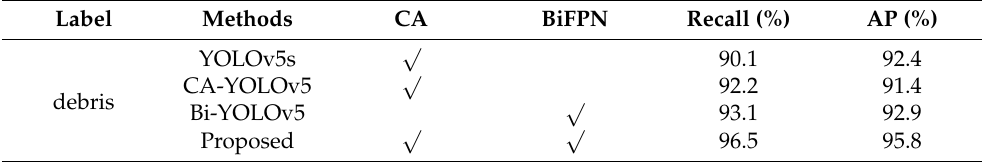
Table 3. The impact of different improvement strategies on the network based on the SWFD